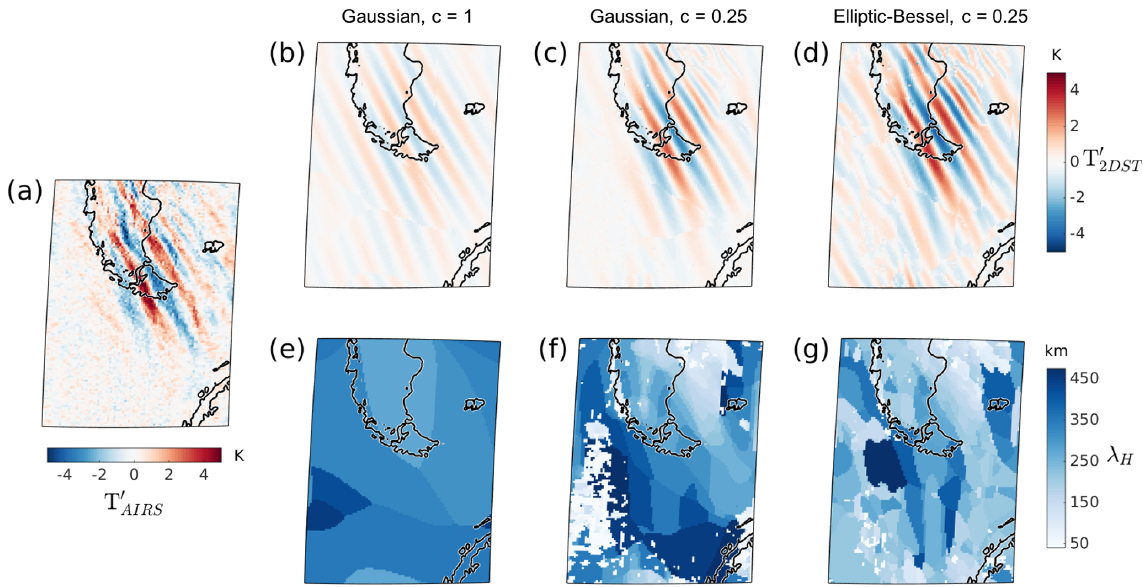
Figure 4. Orthographic projection of AIRS brightness temperature perturbations T (cid:48) 05:30UTC on 24 May 2008, with “reconstructed” temperature perturbations T (cid:48) 2DST with three different windowing approaches: (b, e) a Gaussian window with scaling parameter c = 1, (c, f) a Gaussian window with c = 0 . 25 and (d, g) the Elliptic–Bessel window with c = 0 .